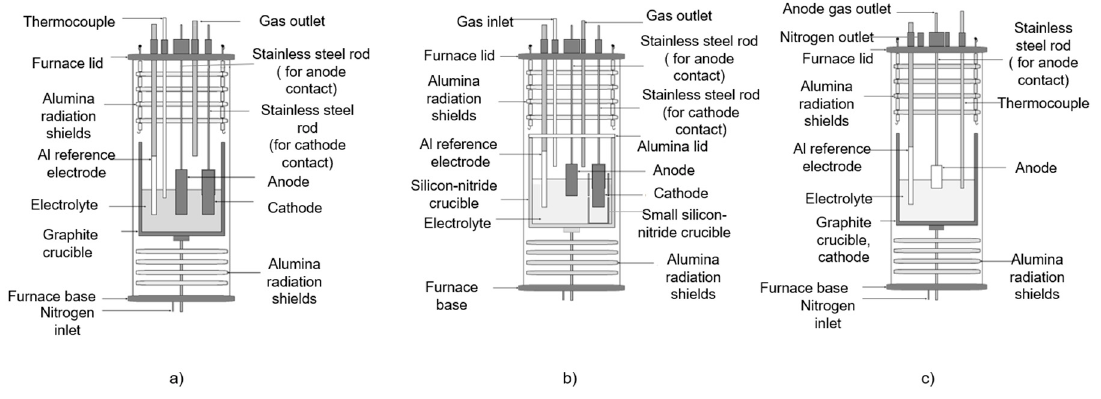
ff erent setups: ( a ) Setup 1, ( b ) Setup 2, ( c ) Setup Figure 4. The three different setups: ( a ) Setup 1, ( b ) Setup 2, ( c ) Setup 3. Figure 4. The three di